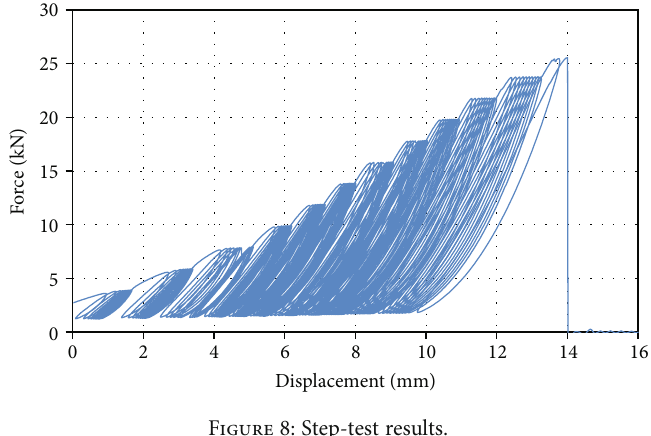
Figure 8: Step-test results.